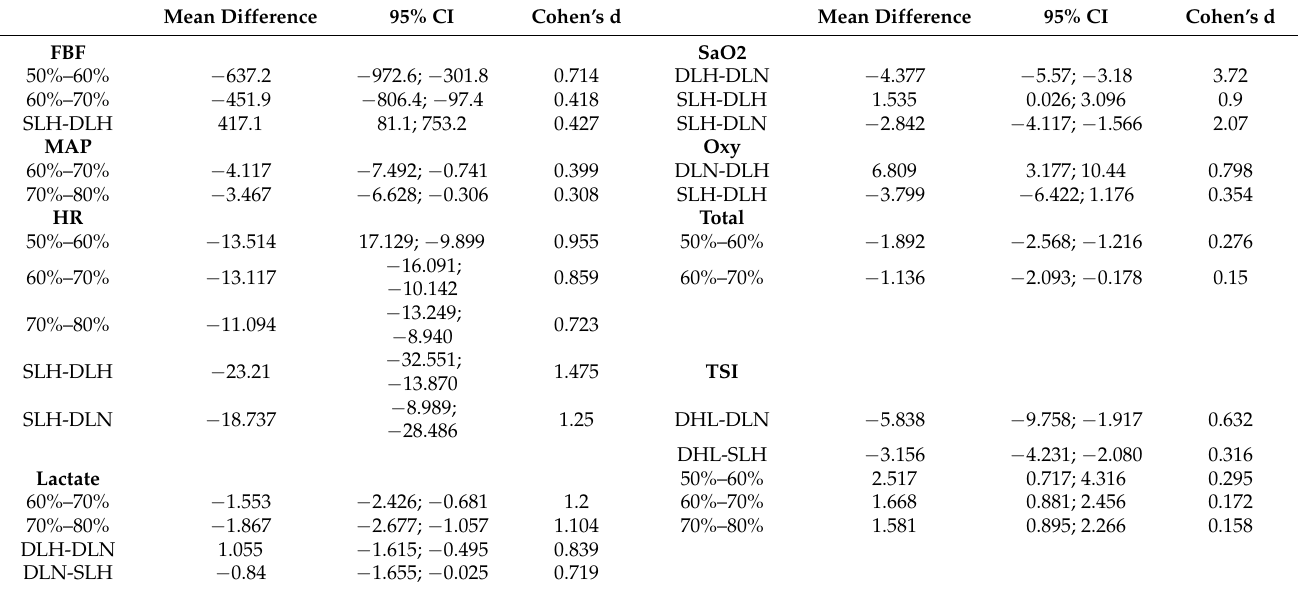
Figure 2. Changes in femoral blood flow between the three conditions and across the four different work rates. * Indicates the significant main effect of work rate on blood flow. Blood flow was not significantly different between 70% and 80% VO 2 peak ( p = 0.10). # Indicates a significant main effect ( p = 0.02) between the single and double-leg trials in hypoxia. DLN = Double-Leg Normoxia; DLH = Double-Leg Hypoxia; SLH = Sigle-Leg Hypoxia. Table 1. Mean difference, 90% CI and effect size for significant